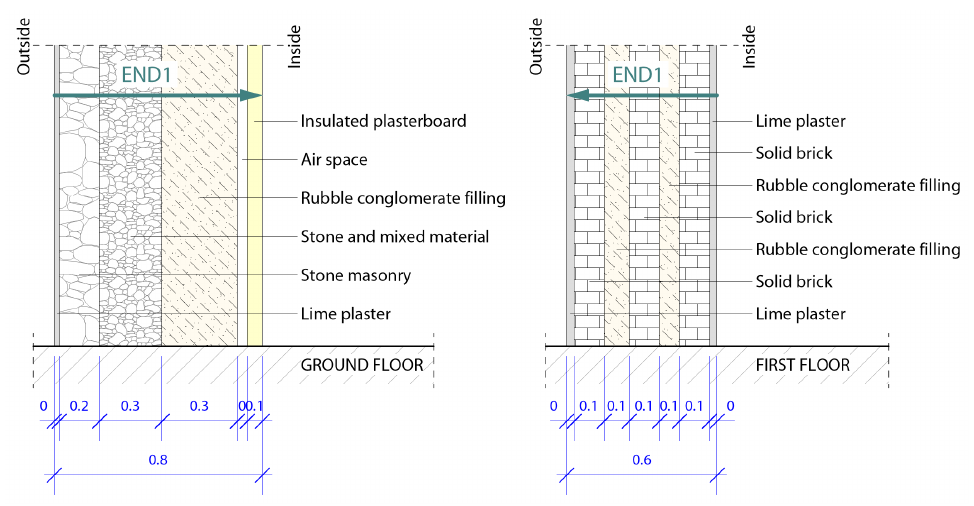
Figure 3. Example of wall characterisation through depth by means of endoscopic tests: stone wall ( left ) and brick wall ( right